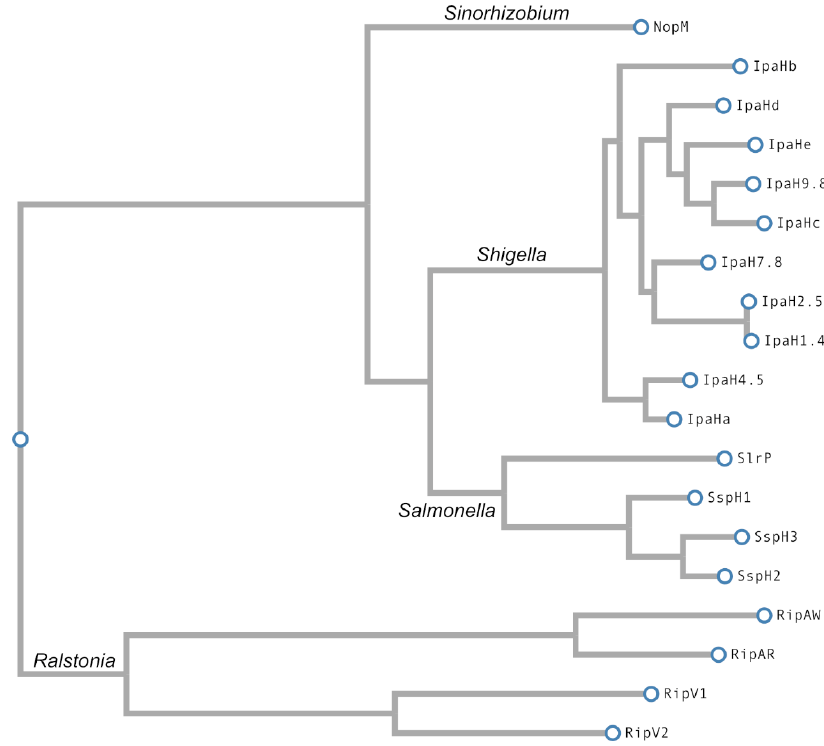
Figure 3. Phylogenetic analysis of NEL effectors. Alignment and phylogenetic reconstructions were performed using the function “build” of ETE3 v3.1.1 [125] as implemented on the GenomeNet (https://www.genome.jp/tools/ete/, accessed on 14 May 2022). Alignment was performed with Clustal Omega v1.2.1 with the default options [126]. The tree was constructed using FastTree v2.1.8 with default parameters [127].